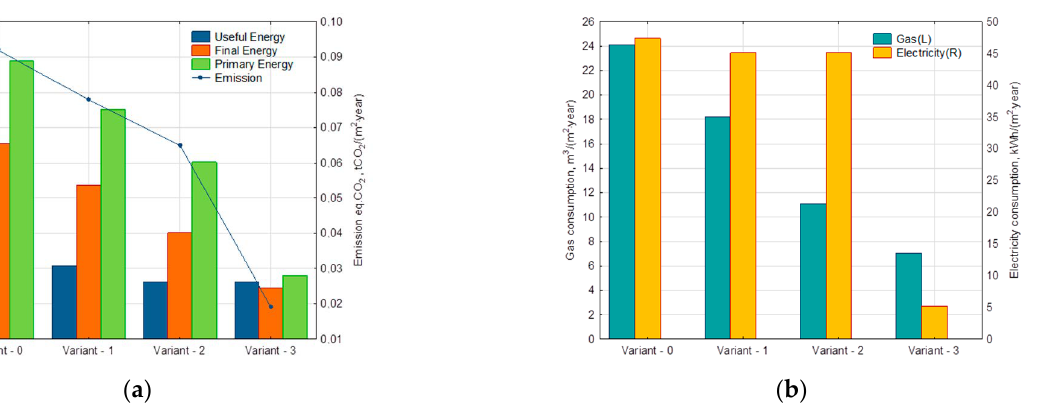
Figure 8. Summary of the energy performance of the building in each of the analyzed variants: ( a ) energy and carbon coefficients; ( b ) electricity (R—right axis) and gas (L—left axis) consumption.